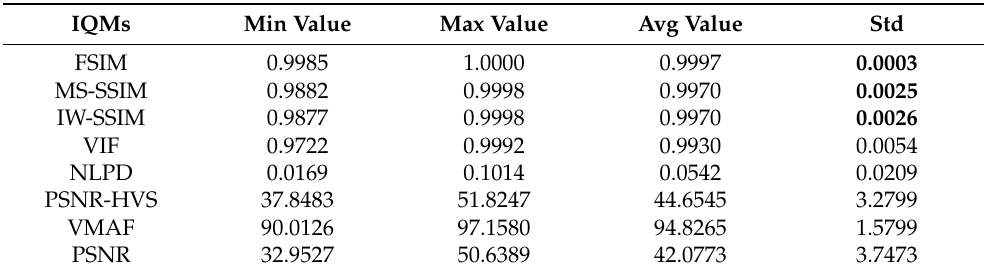
Table 4. Statistical analysis of the IQMs for the corresponding test image guarantees visually lossless compression of the images in the flicker test.